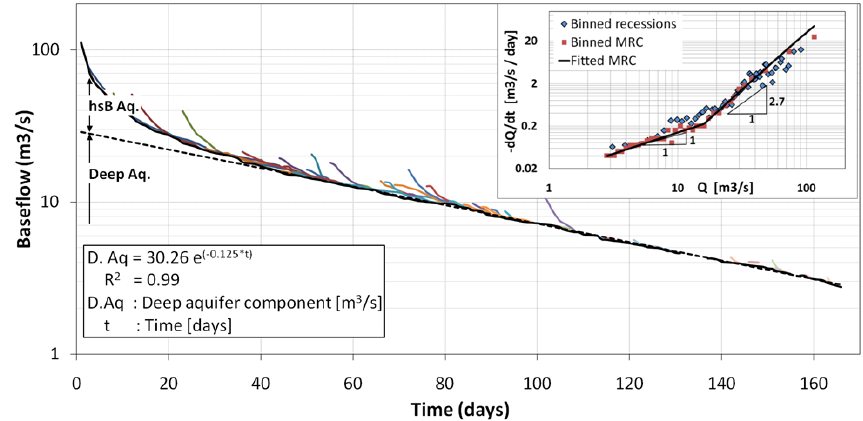
Fig. 1. Illustration of average leaf area index (LAI) curve derived from 9 years of MODIS observations over Tygart River Valley catchment. A cut-off level of 50% of the rescaled LAI curve is used to separate the dormant and the growing season.